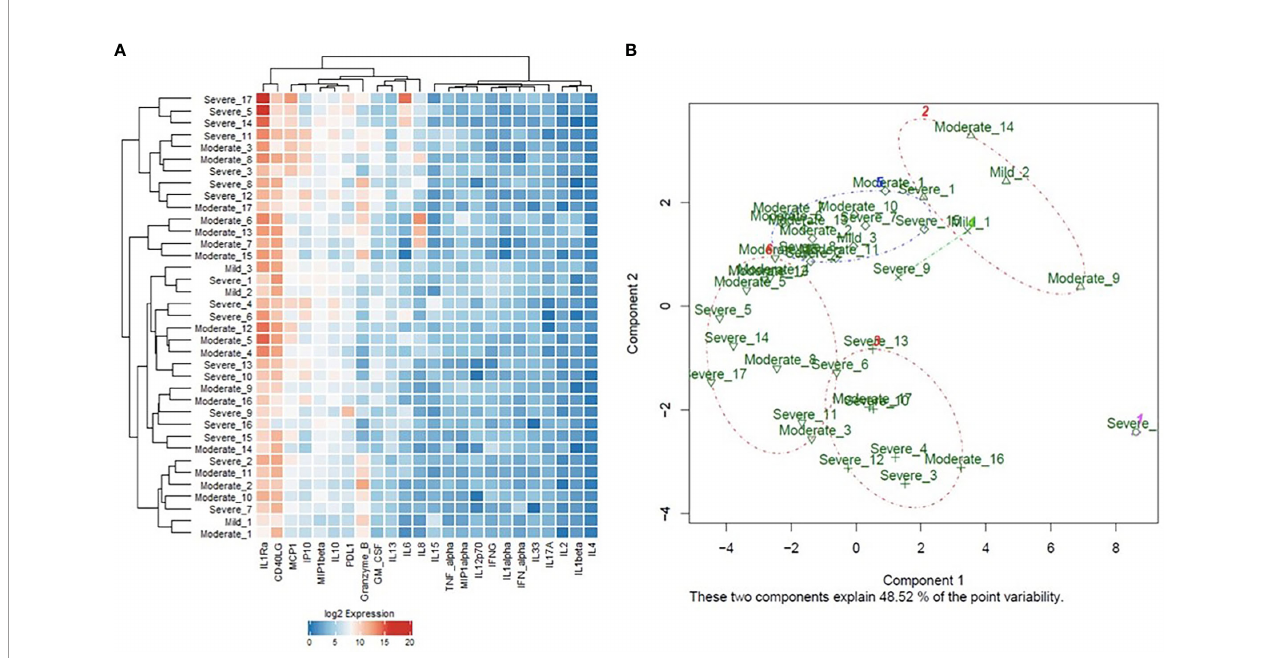
FIGURE 5 | (A) Heat map representation of the unsupervised hierarchical clustering and (B) Principal Component Analysis (PCA) plot representation of the k-means clustering analysis of cytokines protein expression in the blood samples of COVID-19 patients of different degrees of severity (3 mild, 17 moderate, and 17 severe). ROC analysis of the predictive capacity of the cytokines (AUC=0.93 ± 0.037, 95% CI=0.86-1, p<0.0001). ROC analysis of the predictive capacity of the biochemical markers (AUC=0.98 ± 0.02, 95% CI=0.94-1, p<0.0001), identi fi ed using the mathematical models to stratify COVID-19 patients according to disease